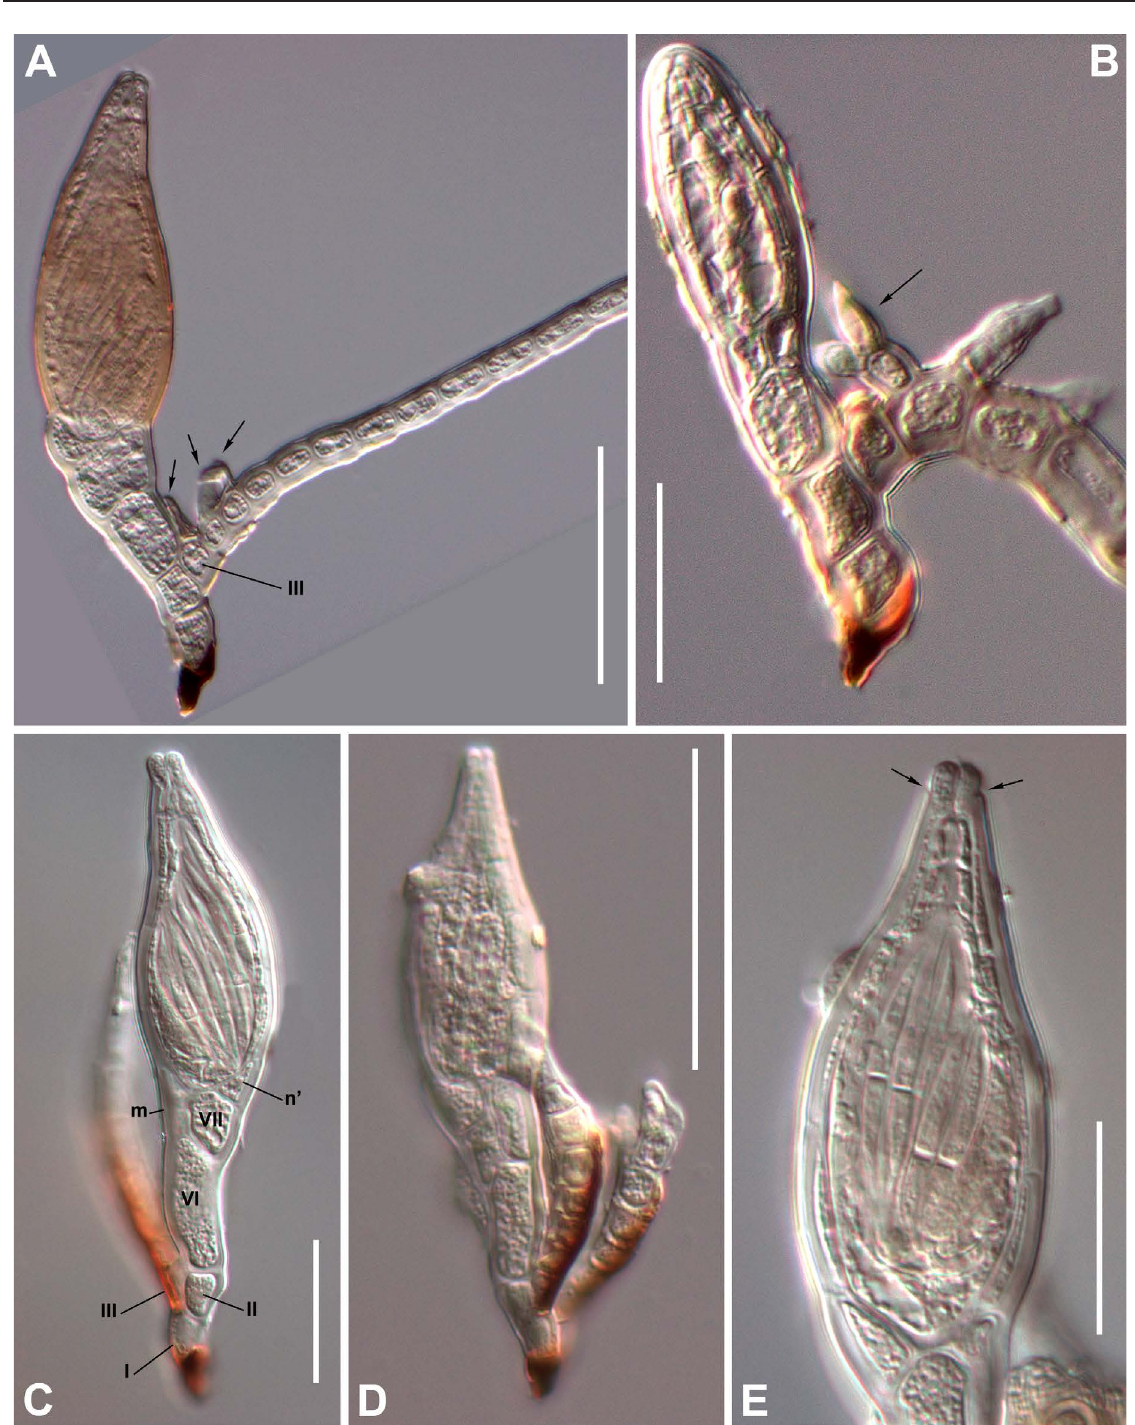
Fig. 51. Cryptandromyces spp. A – B . C. elegans (Maire) W.Rossi & Castaldo. A . Mature thallus showing antheridia (arrows) and cell III. B . Immature thallus with arrow pointing to ramified branch borne on the inner side of the lower cell of the appendage. – C – E . C. euplecti Santam. C . Mature thallus with labelled cells I, II, III, VI, VII, m and n’. D . A pair of thalli with primary appendages in focus. E . Perithecium in detail with lips protruding through a break (arrows) in apex. Scale bars: A, D = 50 µm; B = 25 µm; C, E = 20 µm. Photographs from slides ZMUC C-F-123225 (A), ZMUC C-F-122887 (B), ZMUC C-F- 122946